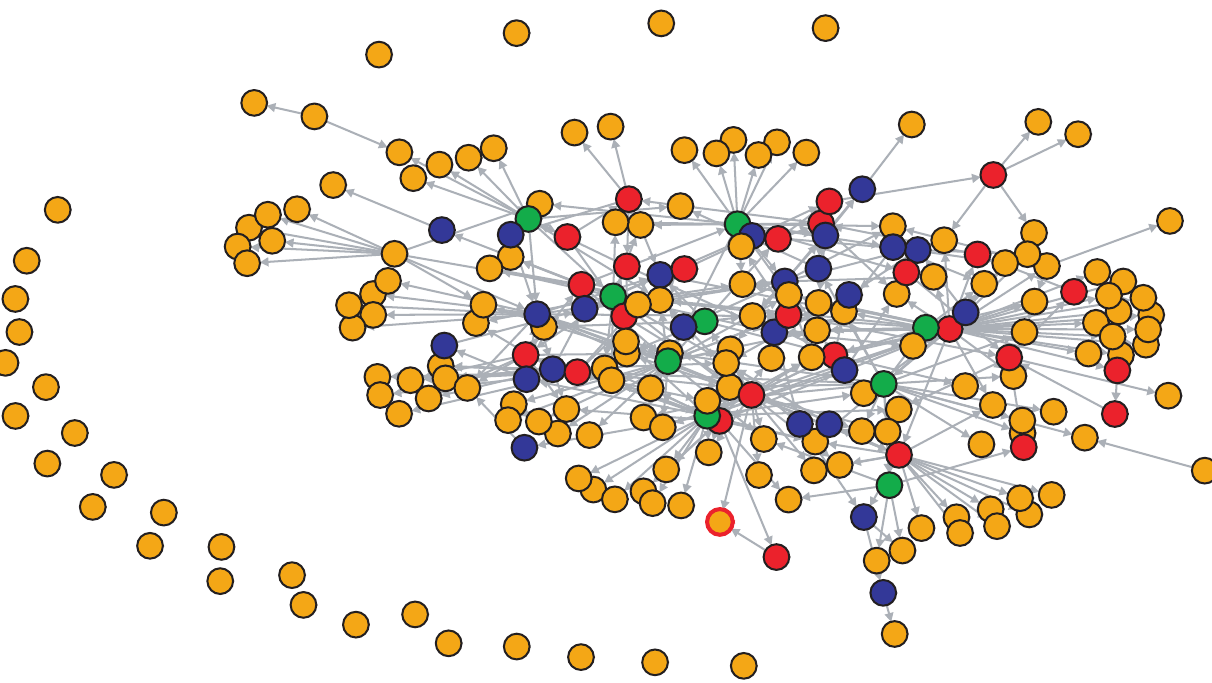
Figure 1. Subnetwork of the TRN of yeast. Shown are 230 genes. Nodes in orange correspond to periodic genes that are not in the SCC (170), green genes are periodic and in the SCC (9), red genes (27) are in the SCC but are not periodic and blue nodes (25) are genes not categorized as periodic according to [18]. The connections shown are shortest paths connecting the periodic genes. All other connections are omitted.